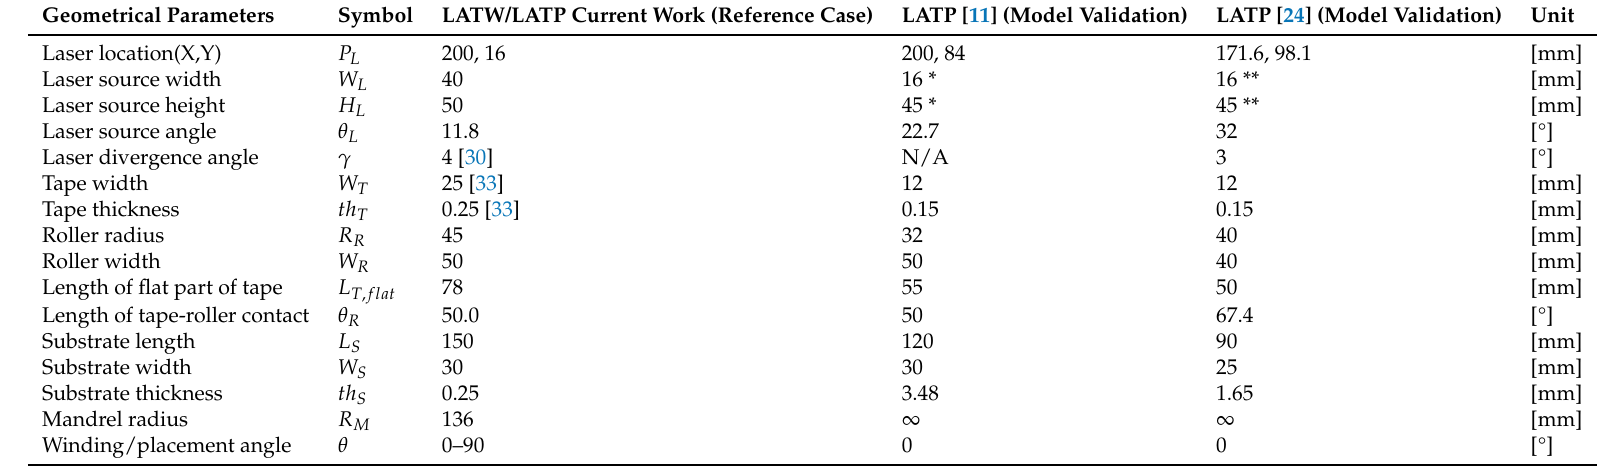
Table 1. Geometrical parameters used in the current modeling work and model validation based on the available data in References [11,24] according to the schematic geometrical model domain given in Figure 2.